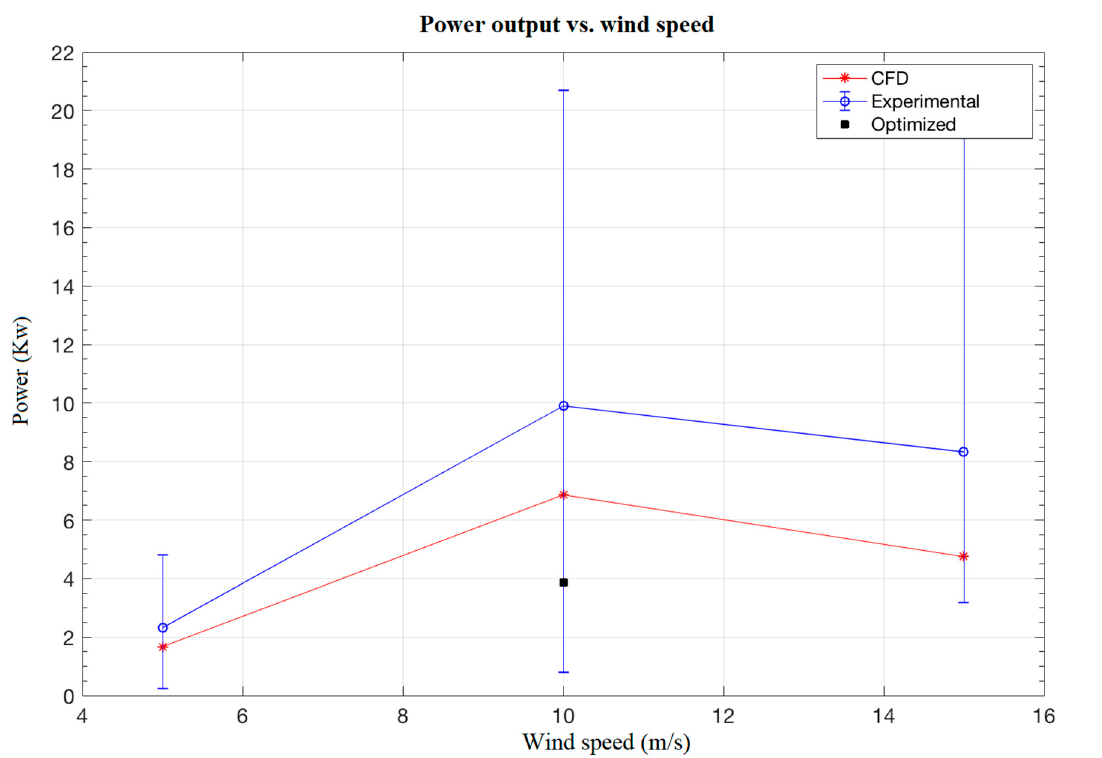
Figure 21. Power output comparison of the original design (experimental data), CFD simulation, and optimized blade.